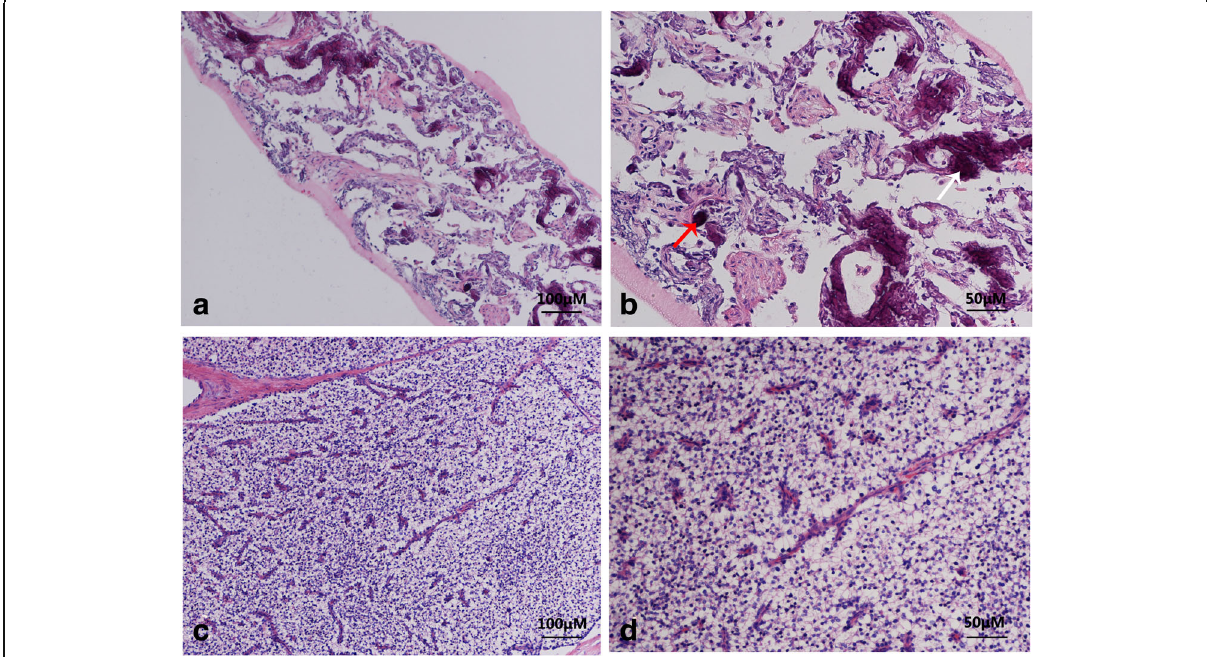
Fig. 3 Representative hematoxylin and eosin (H&E) staining of tissue sections from CT-guided biopsy of left pulmonary a , b and left parathyroidectomy c , d . a The alveoli structure was partially damaged. Fibrosis and interalveolar septa broadening were seen in the pulmonary interstitium with multifocal calcium deposition and irregular-shaped calcified bodies. No obvious inflammatory cell or giant cell reaction was observed in pulmonary interstitium (H&E 100×.). b Multifocal irregularities of calcium deposition and the calcified bodies in the pulmonary interstitium were seen at high magnification (white arrow), some of which resemble the psammoma bodies seen in a thyroid gland papillary carcinoma (red arrow) (H&E 200×.). c Tumor cells were shown as the organ-like tissue structure and the tumor cells were in the nest-like distribution. Branched blood vessels were found between the cells and no tumor necrosis was observed (H&E 100×.). d High magnification revealed the nest-like distribution of tumor cells, which were round or columnar with the cytoplasm being transparent and the nucleus being round or oval. Neither nucleus atypia nor mitotic activity was observed. Sinusoid segmentation could be found between the tumor cells (H&E